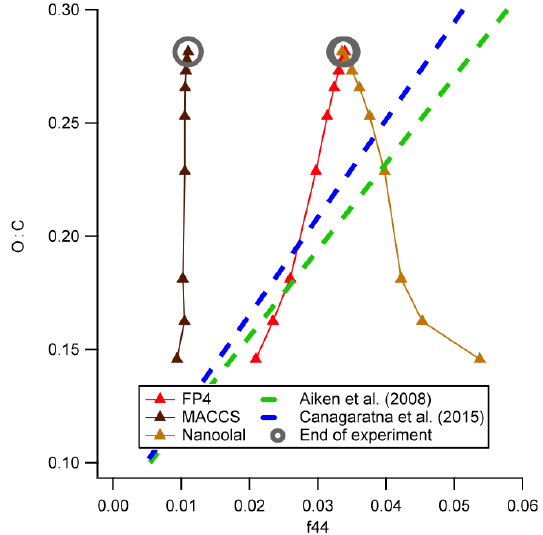
Figure 8. Comparison of O:C ratios and predicted fractional con- tribution to the AMS m/z 44 channel ( f 44 ) for the Valorso et al. (2011) GECKO-A simulation, compared against the regressions performed by Aiken et al. (2008) and Canagaratna et al. (2015). The highlighted points indicate the final points in the simulation.